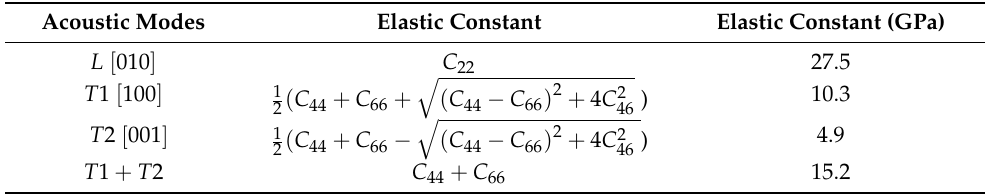
Table 2. The correlation between the three acoustic modes and the elastic constants obtained from the present scattering geometry. The numerical values are measured at 20 ◦